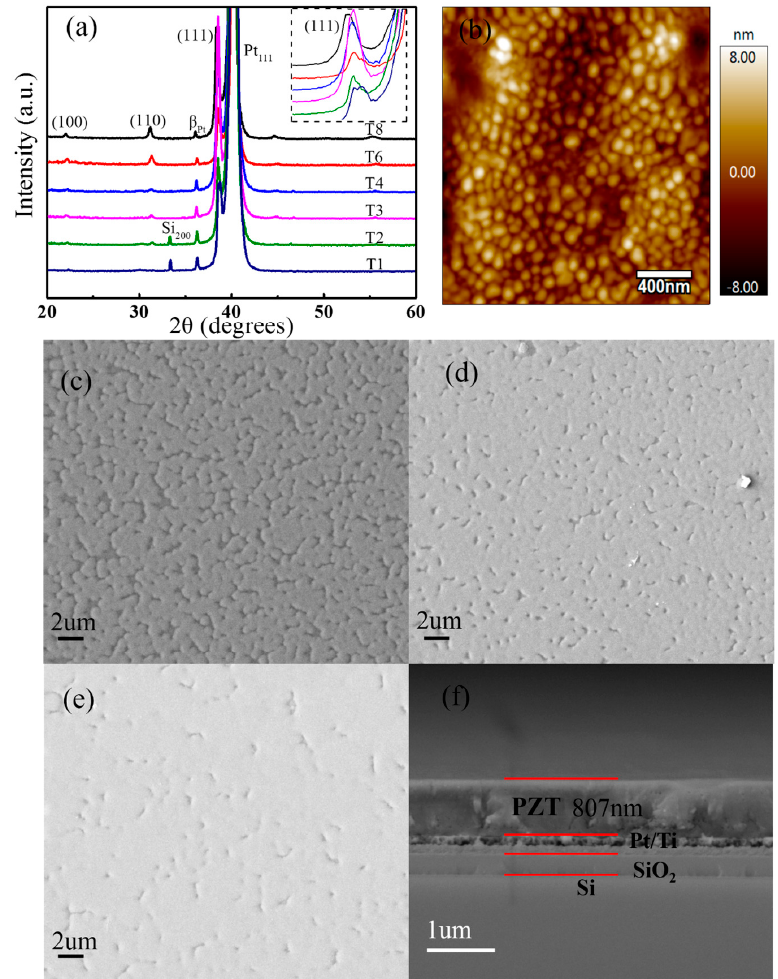
Figure 2. ( a ) XRD pattern of PZT films prepared on Pt/Ti/SiO 2 /Si substrates with different thicknesses a . ( b ) AFM surface morphology in area of 2 μ m × 2 μ m of PZT-8. Top-view of ( c ) PZT-4, ( d ) PZT-6 and ( e ) PZT-8 and ( f ) cross-sectional SEM images of PZT-8. The inset of Figure 2a presents the local enlargement of (111)